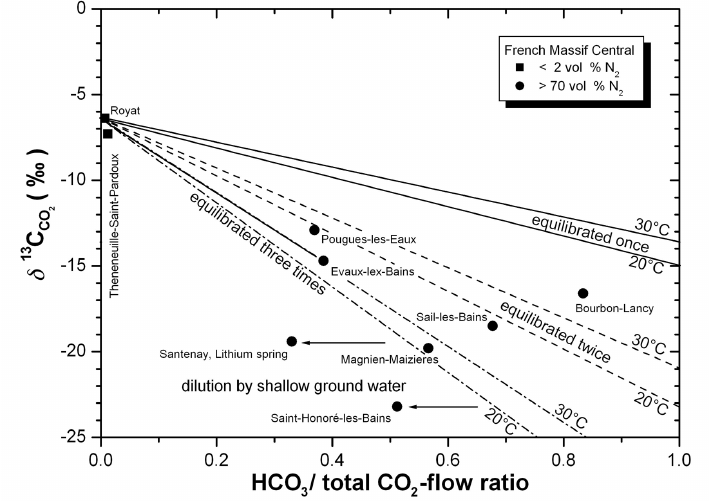
– transport ( m HCO 3 ) to total CO 2 flux ( m 0 ) for 3